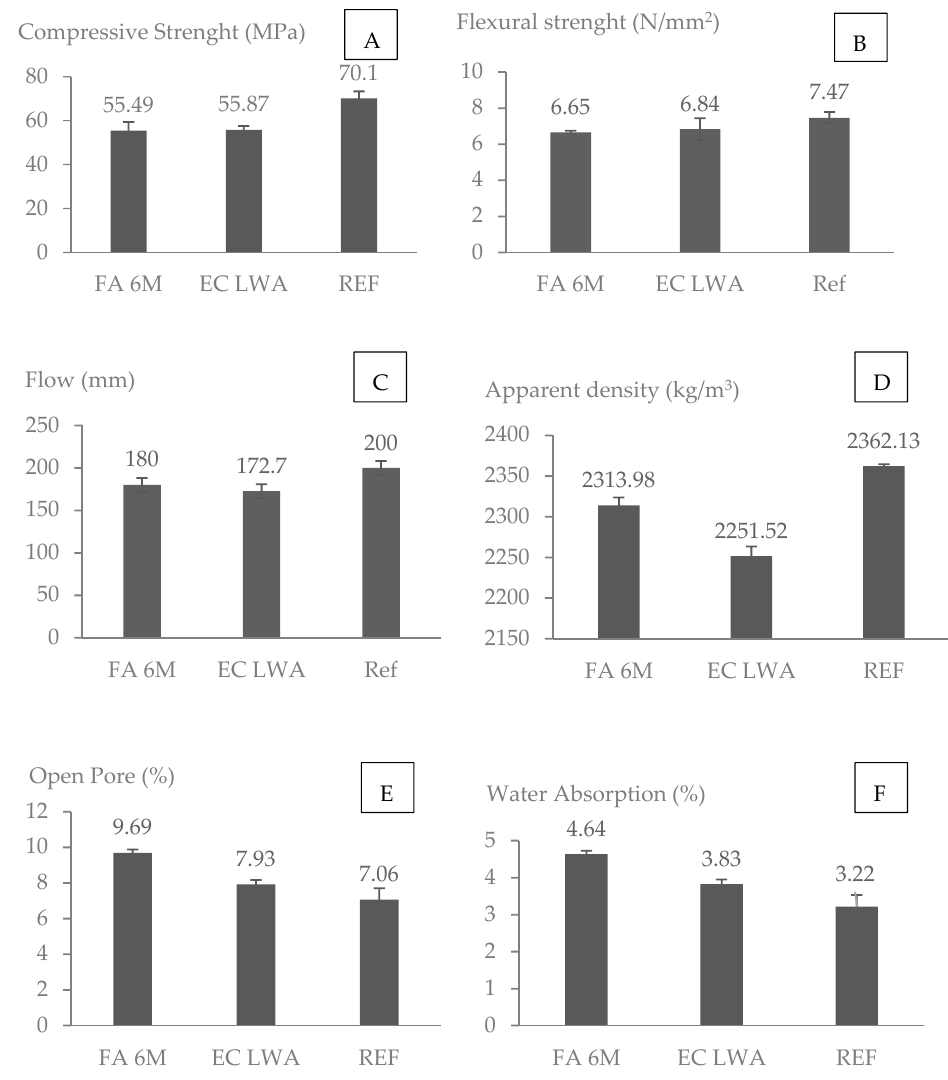
Figure 6. Physical properties of resulting mortar: ( A ) the compressive strength; ( B ) Flexural Strength; ( C ) Workability of Fresh Mortar; ( D ) Apparent Density; ( E ) Open Pores and ( F ) Water Absorption over 24 h.